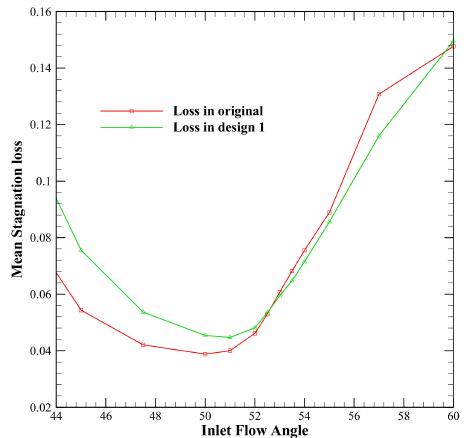
Figure 29. Variation of loss coefficient and deviation flow angle versus inlet flow angle for the current and second designed blade